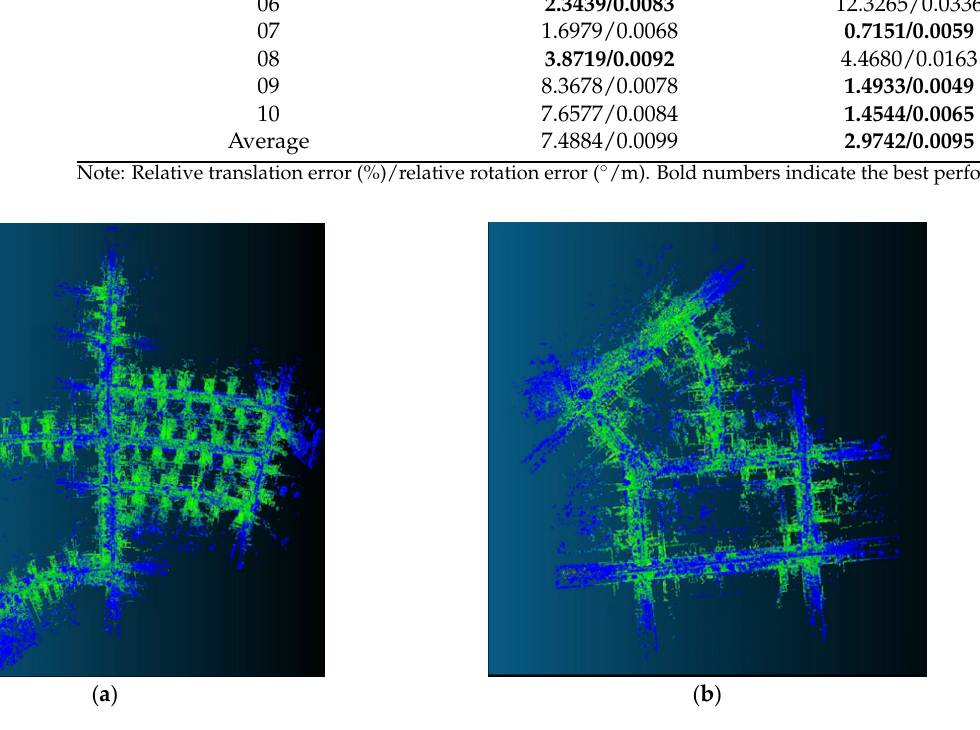
Figure 13. Mapping trajectory: ( a ) mapping trajectory of sequence 05 on the KITTI dataset; ( b ) mapping trajectory of sequence 07 on the KITTI dataset.